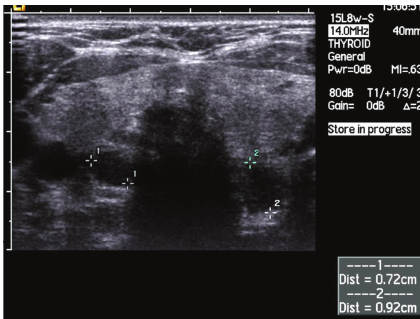
Figure 1: An ultrasound scan demonstrating hypoechoic nodules (outlined by caliper markings) inferior to both thyroid nodules highly suggestive of parathyroid adenomas.